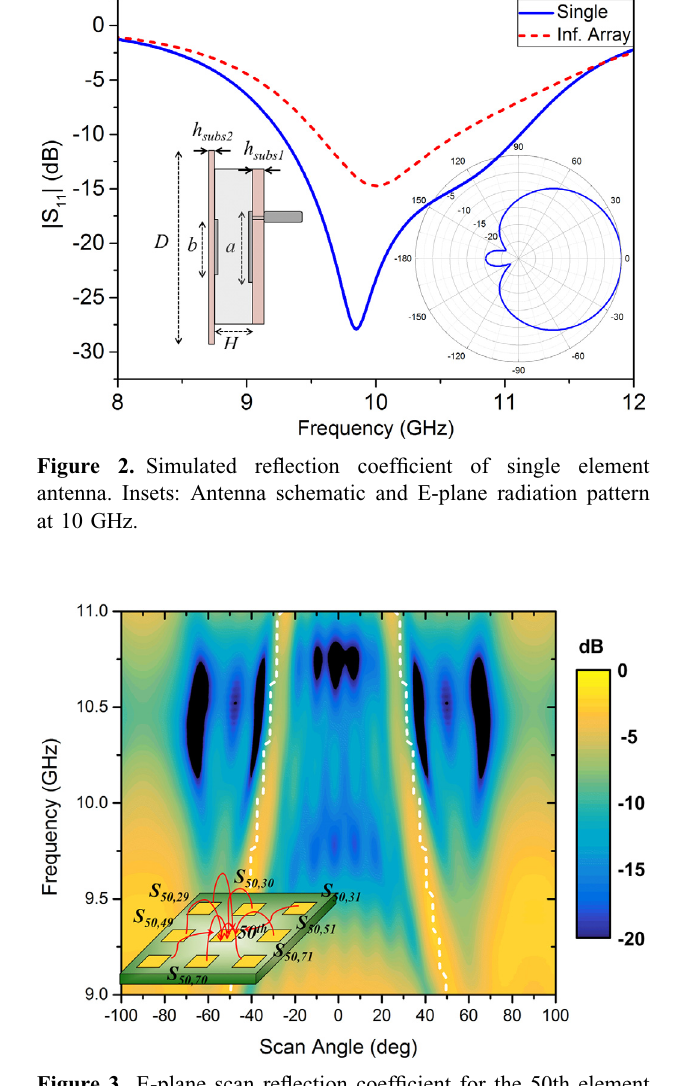
Figure 3. E-plane scan reflection coefficient for the 50th element over frequency and angle of incidence (scale in decibels). Dashed white line corresponds to theoretical result of the onset of the first grating lobe. Inset: Schematic of coupling coefficients contribution for one element active reflection coefficient.